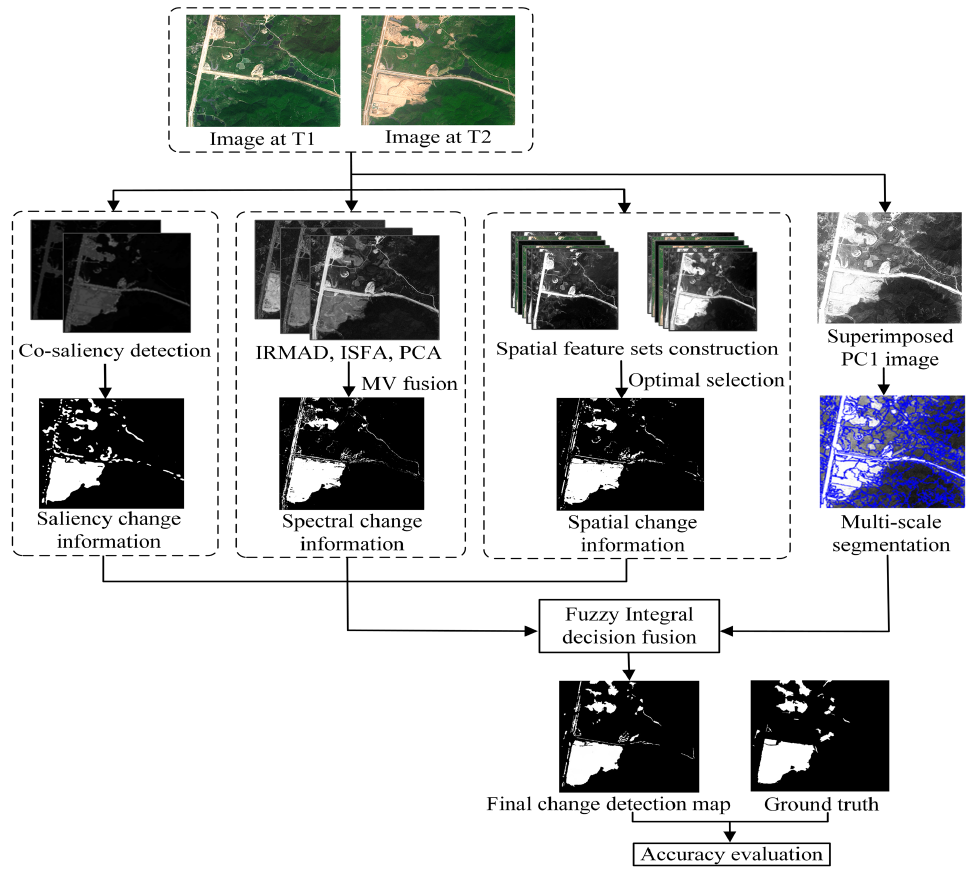
Figure 1. Framework of the proposed change detection approach.